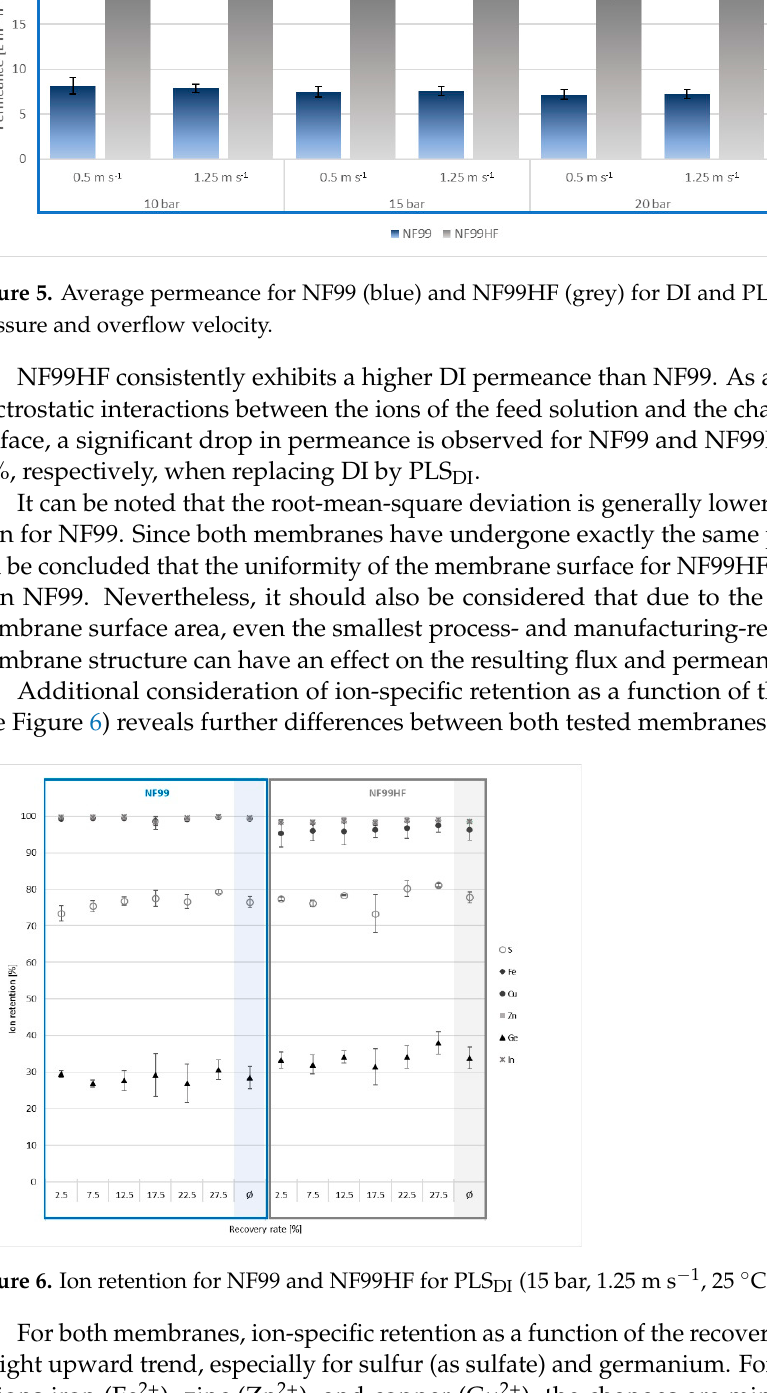
Figure 5. Average permeance for NF99 (blue) and NF99HF (grey) for DI and PLS DI as function of pressure and overflow velocity.